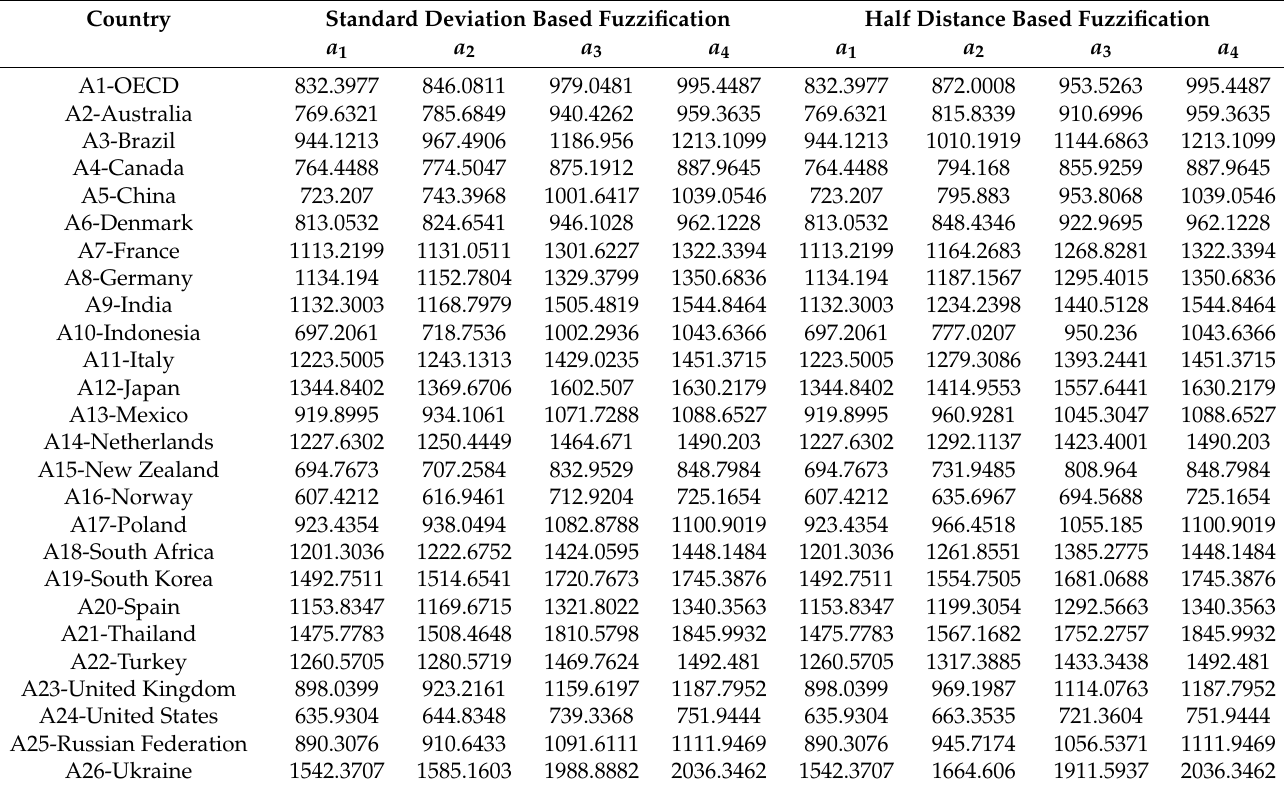
Table A1. IESRI fuzzy values forecasted for the 2020–2030 period, obtained using the forecasted metric values. Country